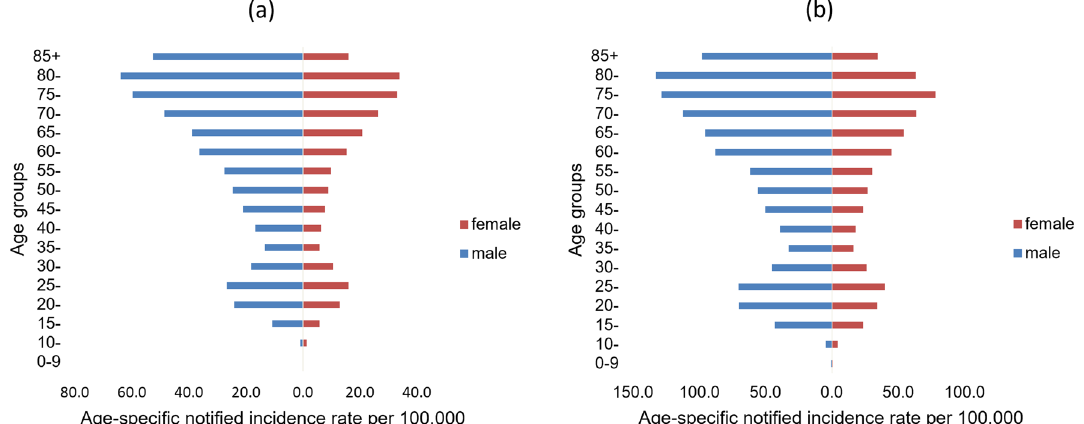
Figure 1. Age-specific notified incidence rate of BP-PTB and BN-PTB.